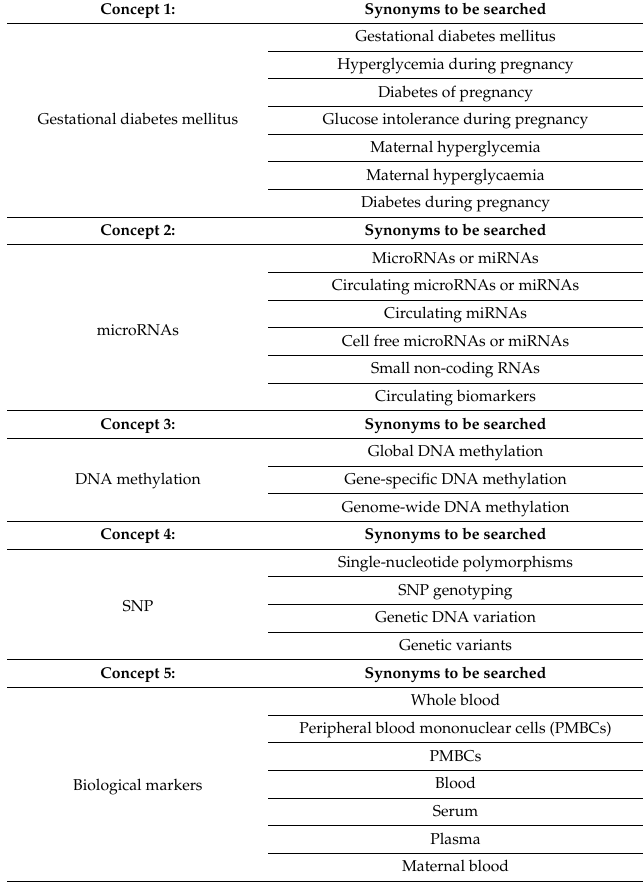
Table A1. Search terms, including gestational diabetes mellitus, blood, single-nucleotide polymorphism, DNA methylation, and microRNAs, and corresponding synonyms